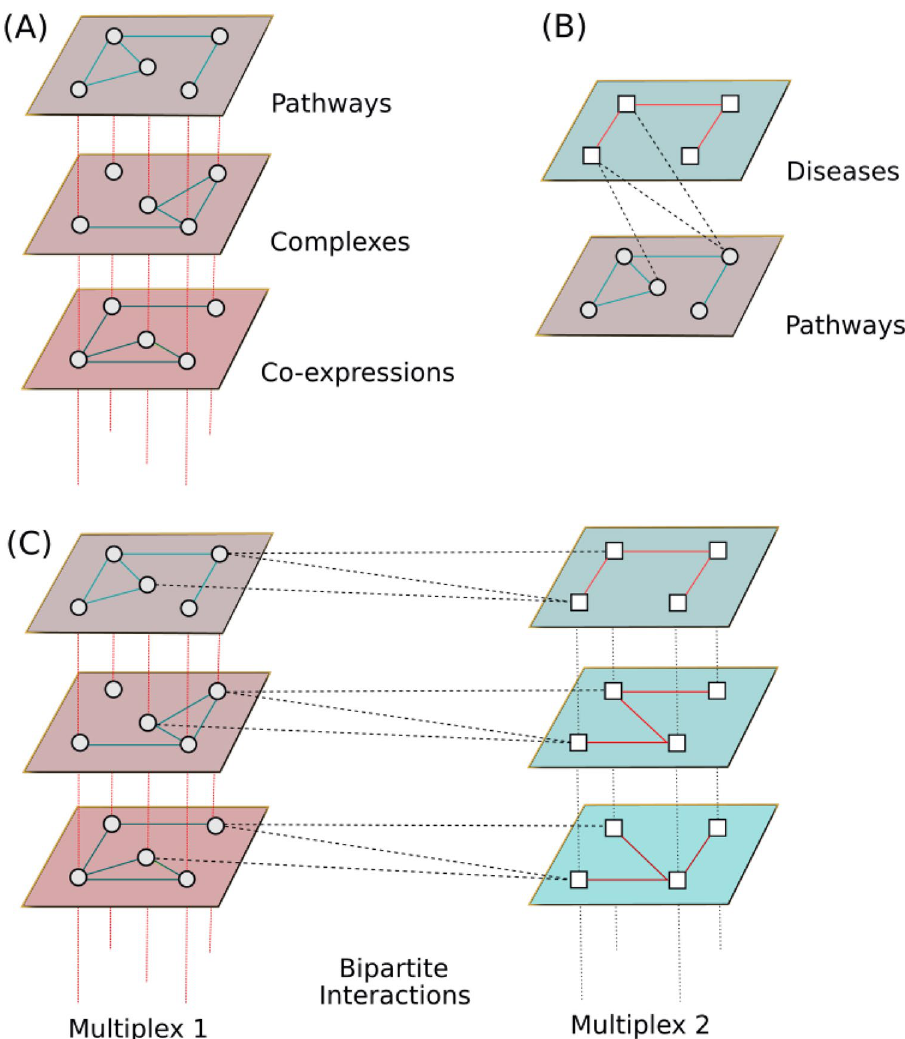
Figure 1. Illustrations of the different types of networks. ( A ) A multiplex network. The different layers share the same set of nodes but different types of edges. ( B ) A heterogeneous network. The two networks are composed of different types of nodes and edges, connected by bipartite interactions (black dashed lines). ( C ) A multiplex-heterogeneous network composed of two multiplex networks. The multiplex networks are connected by bipartite interactions (dashed lines). For the sake of simplicity, the figure does not represent all the possible bipartite interactions (each layer of a given multiplex is in reality linked with every layer of the other